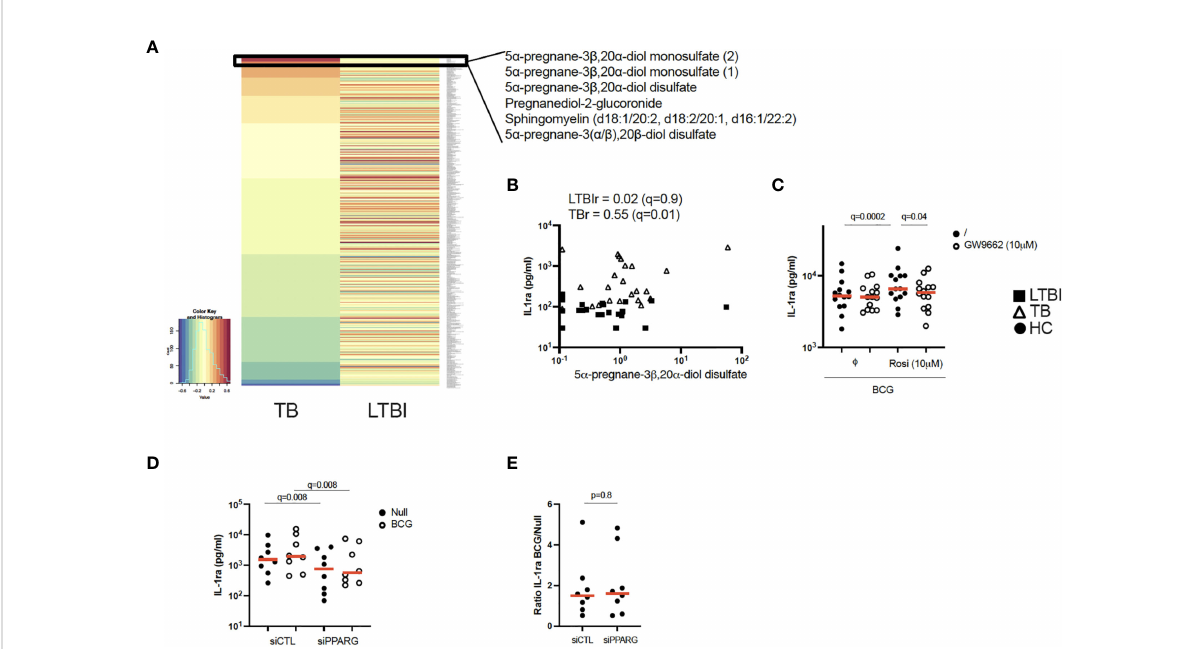
FIGURE 3 Pregnane steroids activate the PPAR g pathway resulting in increased IL-1ra secretion in active TB. (A) Heatmap of Pearson correlation coef fi cients between metabolites and IL-1ra protein in the Null condition, measured by mass spectrometry and Luminex, respectively, for TB (left) and LTBI (right). Metabolites are ordered in decreasing values of TB cases Pearson correlation coef fi cients. (B) Pearson correlation between IL-1ra levels measured by Luminex and 5 a -pregnane-3 b ,20 a -diol disulfate measured by mass spectrometry for LTBI and TB. (C) IL-1ra protein concentration measured by ELISA after stimulation of CD14+ monocytes from healthy individuals with BCG in the presence or absence of the PPAR g agonist rosiglitazone (Rosi) and/or the PPAR g antagonist GW9662 (n=14, 4 independent experiments). (D) IL-1ra protein concentration measured by ELISA after stimulation with BCG of PPARG silenced or control CD14+ monocytes from healthy individuals (n=8, 3 independent experiments). (E) Ratio of IL-1ra induced upon BCG stimulation versus the Null Control in PPARG silenced or control CD14+ monocytes (n=8, 3 independent experiments). Comparisons between groups were performed using paired non-parametric t-tests and correction for multiple comparisons was applied. Red line: median values. Closed square: LTBI, Open triangle: TB, Circle: Healthy Control (HC). For panels (B – D) , q values (false discovery rate-adjusted p values) are